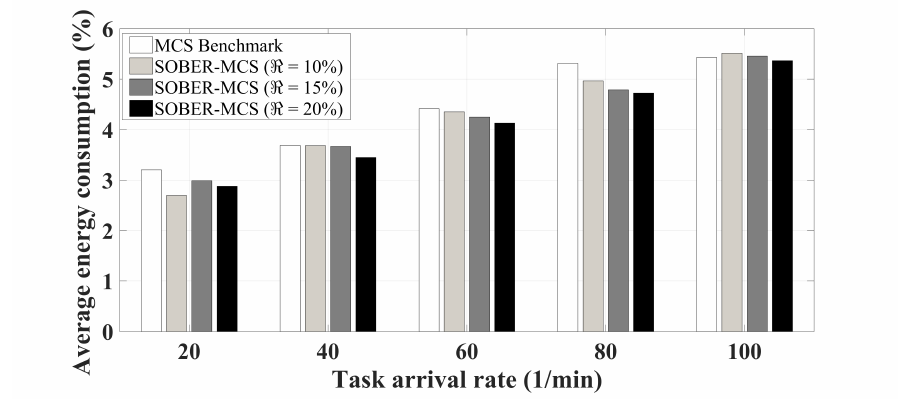
Figure 12. Average energy consumption.